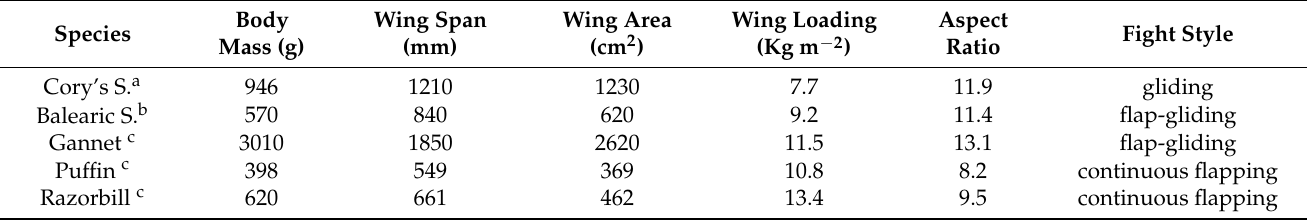
Table 1. Morphological characteristics (body mass, wingspan, wing area, and aspect ratio) and flight behaviour of the study species are arranged by increasing flapping flight style. Flight styles were categorised from direct observations of the commonest style amongst all individuals observed during migration (unpublished